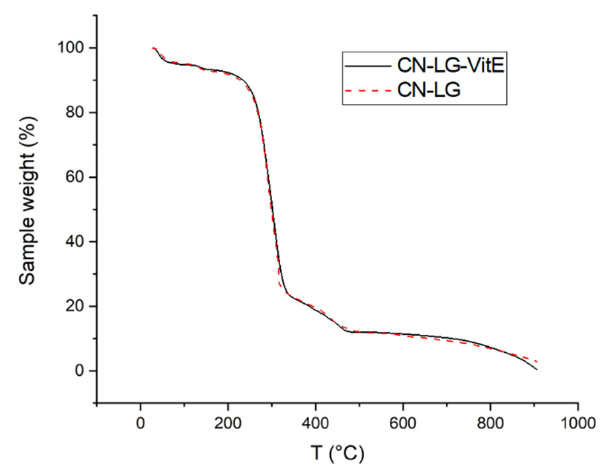
Figure 4. TGA thermograms of chitin nanofibrils–nanolignin–Vitamin E complex (CN-LG-Vit-E) and chitin nanofibrils–nanolignin complex (CN-LG).